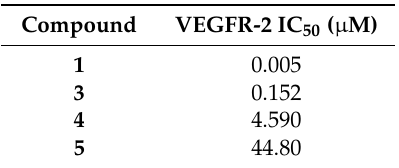
Table 1. Inhibitory activity of parent and caged compounds in a VEGFR-2 kinase assay (ProQinase, Freiburg, Germany) [40]. The IC 50 values are presented.